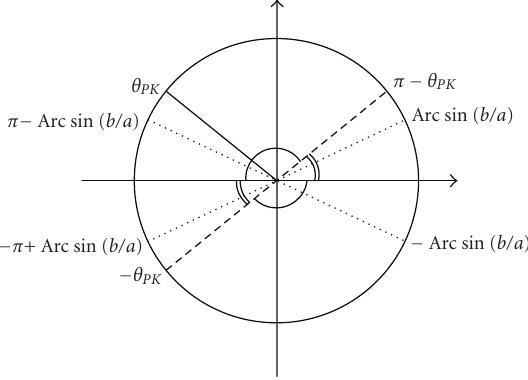
Figure 9: The angle boundaries versus primary search